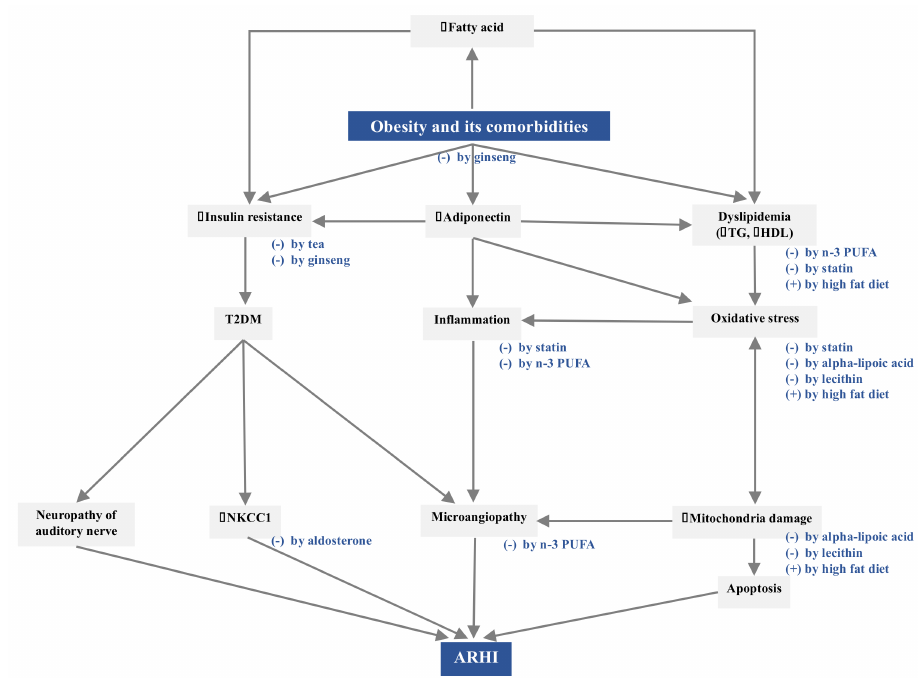
Figure 1. Pathogenetic mechanisms linking obesity and comorbidities to ARHI and the corresponding nutritional interventions. The symbol of ( + ) indicates stimulation and (-) means